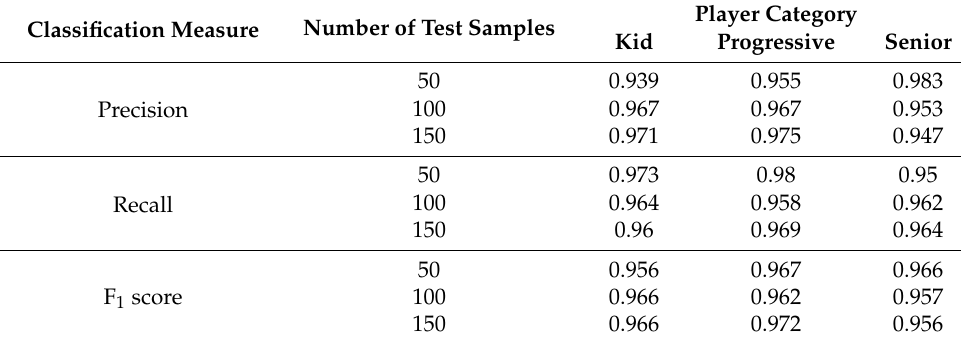
Table 6. Player classification results for the NN 3 (trained with 450 samples). Classification